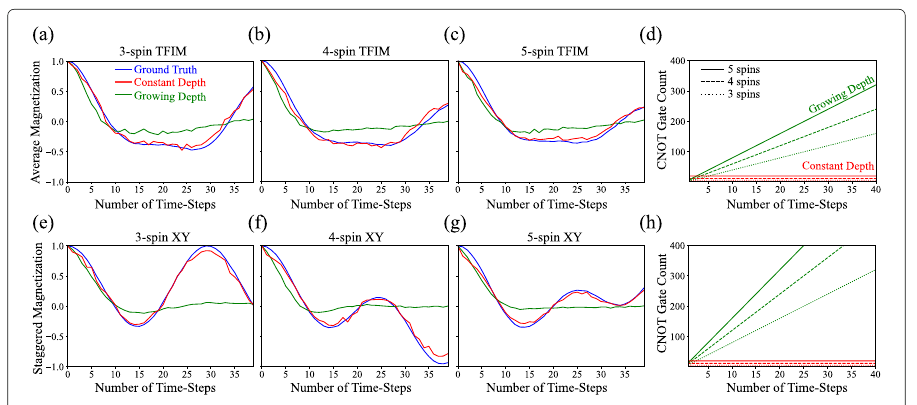
Fig. 3 Comparison of simulation results from real quantum hardware and CNOT gate count for the TFIM and XY model using the constant-depth circuits versus growing depth circuits generated from standard Trotter decomposition. The top row shows simulation results for a TFIM with 3- ( a ), 4- ( b ), and 5-qubits ( c ). A noise-free simulator provides the ground truth, shown in blue, with which to compare results from the constant-depth circuits (red) and growing depth circuits (green). The bottom row shows the analogous simulation results for the XY model with 3- ( e ), 4- ( f ), and 5-qubits ( g ). d and h show the number of CNOT gates in the constant-depth (red) and growing depth (green) circuits for each time-step for 3- (dotted line), 4- (dashed line), and 5-qubit (solid line) systems for the TFIM and XY models,